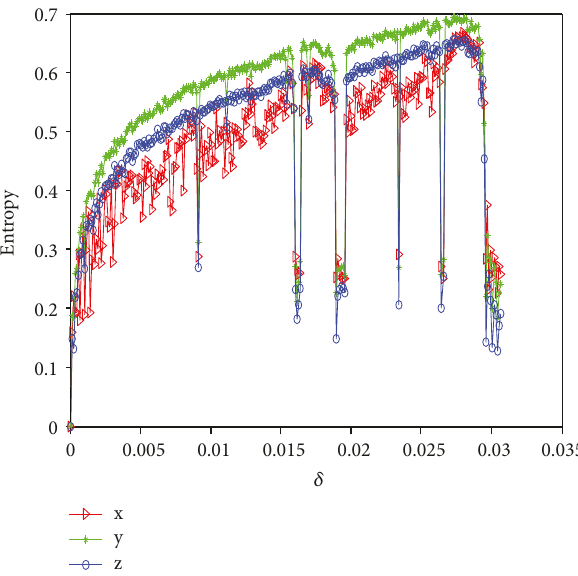
Figure 12: The spectral entropy complexity of system (2) versus step size δ ∈ 0, 0 035 with a , b = 28, 3